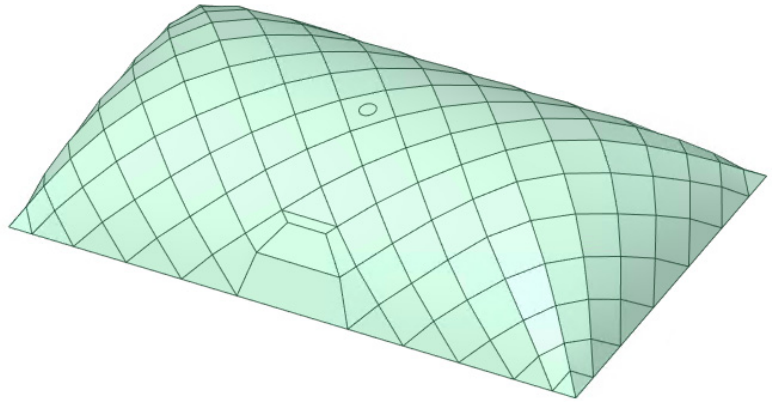
Figure 2. Geometry of the CFD model.